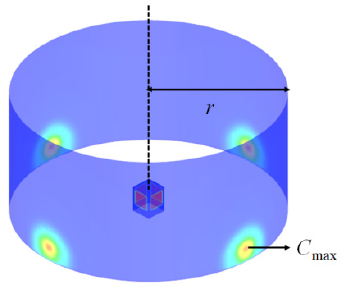
Figure 17. C max diagram.